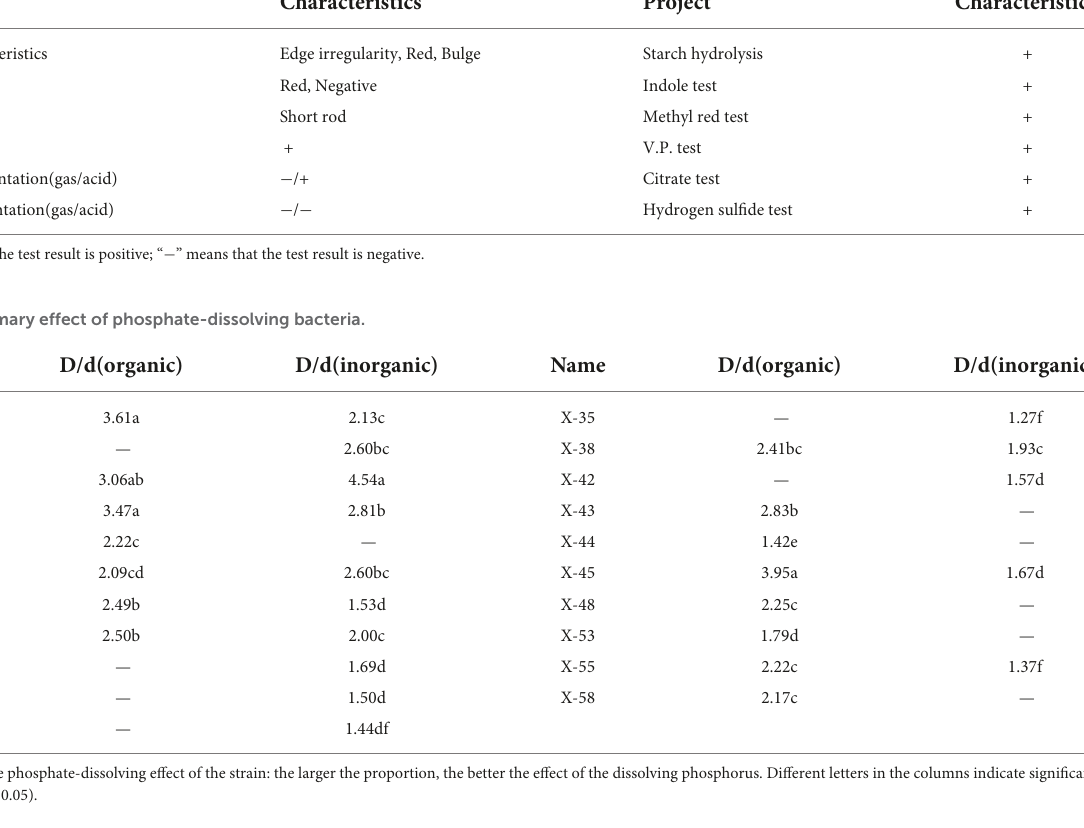
TABLE 3 Composition of rock